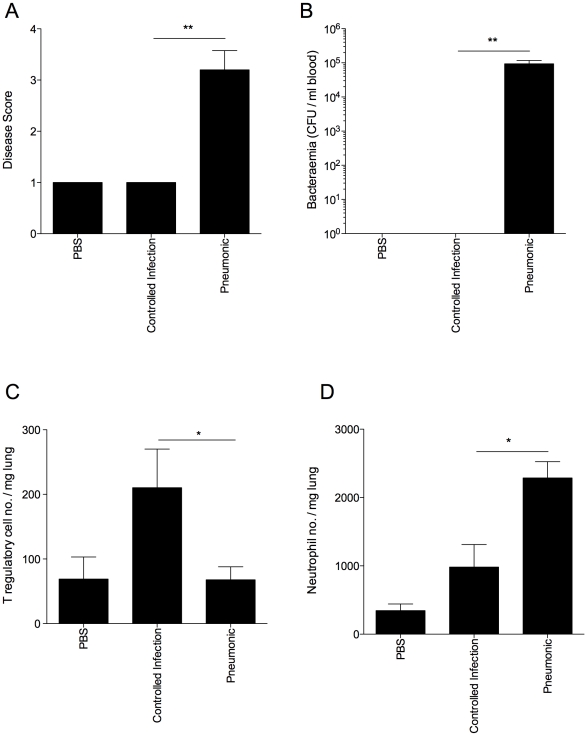
Disease resistance in outbred MF1 mice correlates with strong T regulatory cell responses in the lung.All results are from intranasal-infection of outbred MF1 mice with wild-type S. pneumoniae D39. (A) Animal disease score at 48 hours p.i. A score of 1 is a normal mouse. Any infected mouse scoring 1 at 48 hours p.i. was considered to have a controlled infection. (B) Number of bacteria/ml blood at 48 hours p.i. CFU=colony forming units. Number of Foxp3+ T regulatory cells (C) and Gr-1hiF4/80lo neutrophils (D) per mg lung in PBS-treated or S. pneumoniae-infected MF1 mice at 48 hours p.i., as identified in flow cytometry. *'s indicate significant difference, where *=p<0.05 and **=p<0.01. For all graphs data represent mean +/− SEM. Results are representative of 2 independent experiments, each with 3 PBS-treated and >10 infected mice.